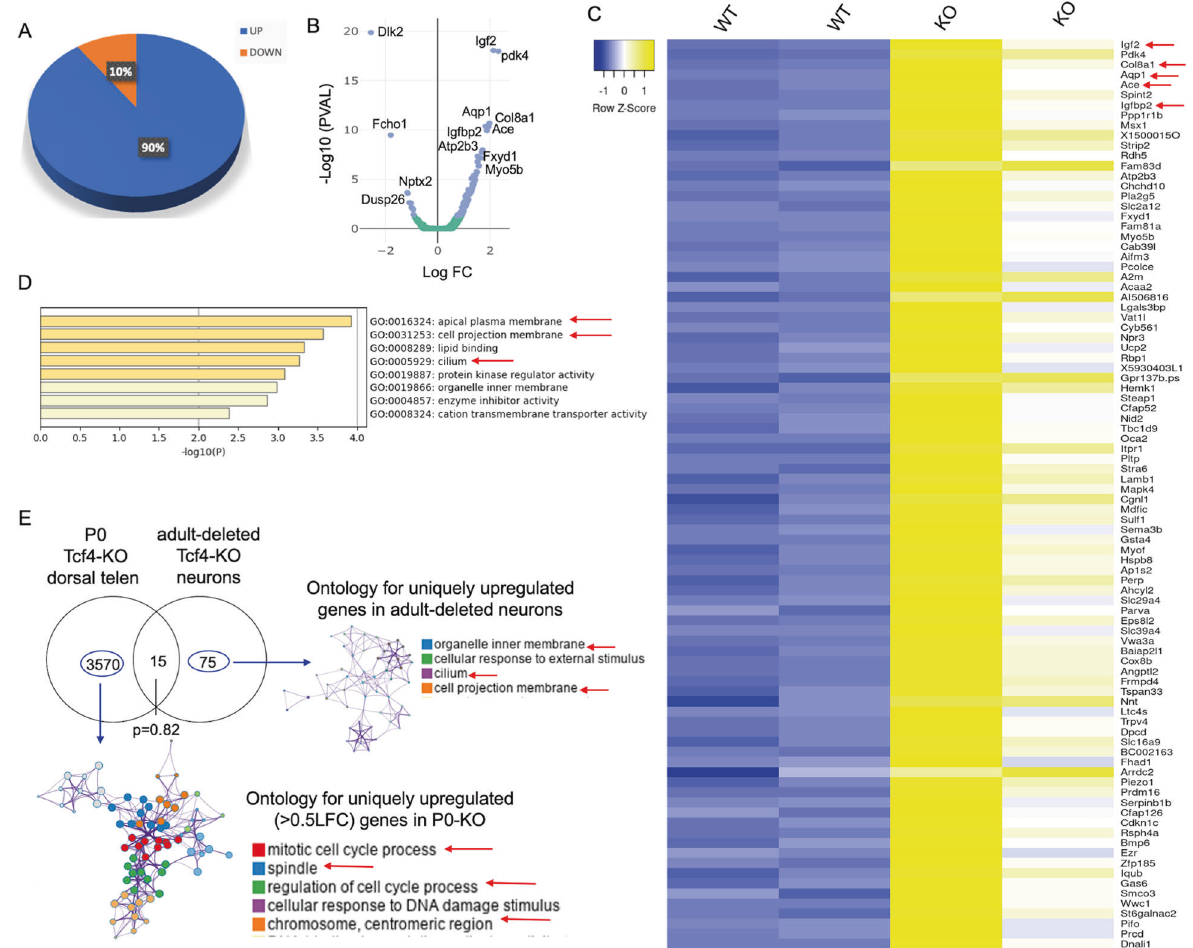
Fig. 5 Tcf4 targets membrane-related gene networks in adult neurons. A Pie chart showing percentage up- or downregulated genes among total DEG in hippocampal mature neurons after Tcf4 deletion. B Volcano plot showing differential gene expression in WT and KO FACS-sorted GFP + neurons (blue dots represent p < 0.05). C Heatmap showing upregulated genes in Tcf4-KO neurons, red arrows highlighting growth factor, membrane transport, and ECM-related genes. D Gene Ontology analysis of upregulated genes in Tcf4-KO mature neurons, red arrows highlighting plasma membrane and cilia-related GO terms. E Meta-analysis of transcriptome from FACS-sorted adult-deleted Tcf4-KO neuron and Tcf4-KO P0 telencephalon showing distinct Tcf4 targets in mature neurons versus developing brain, LFC: log fold change, telen: telencephalon, Fisher ’ s exact test p value = 0.82 shows insigni fi cant